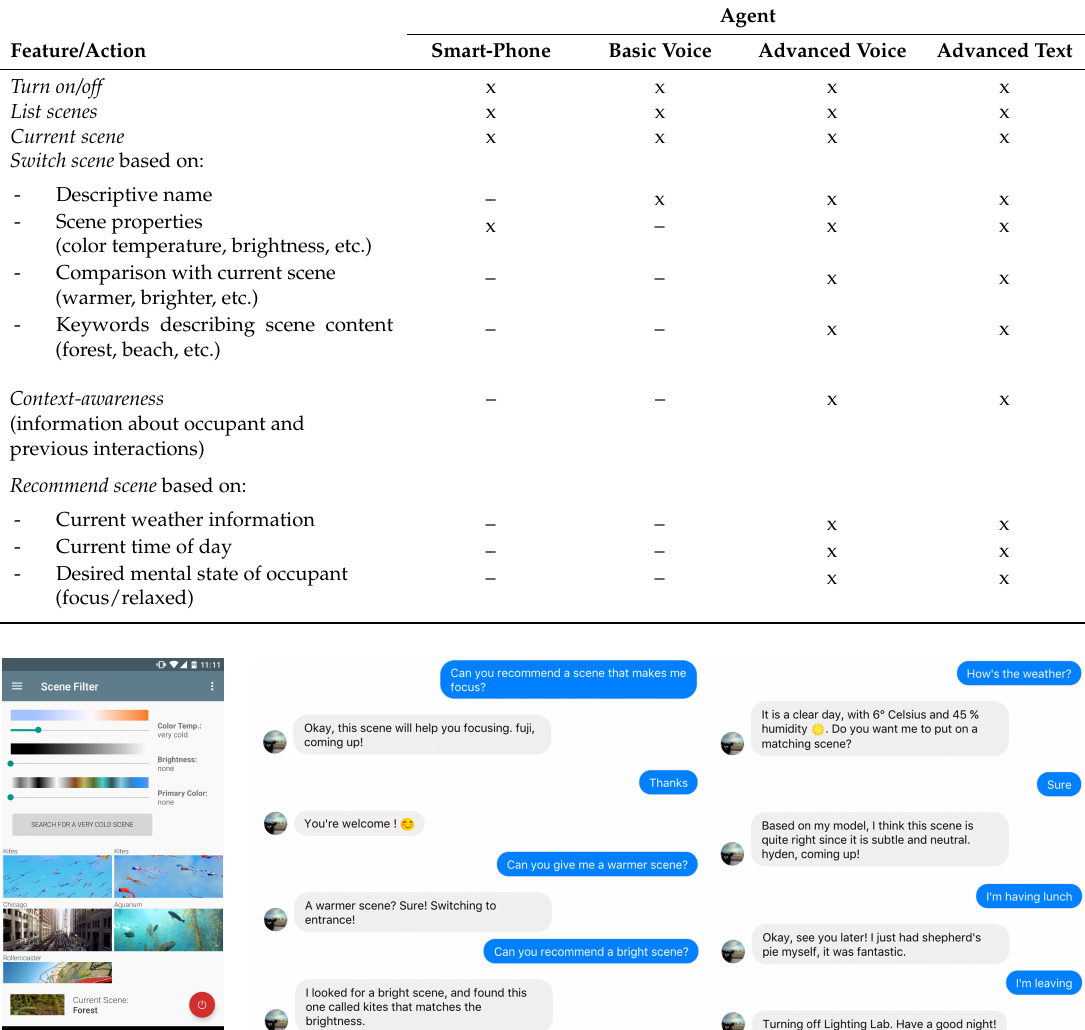
Table 1. Feature range of agents. x = available, – = not available.